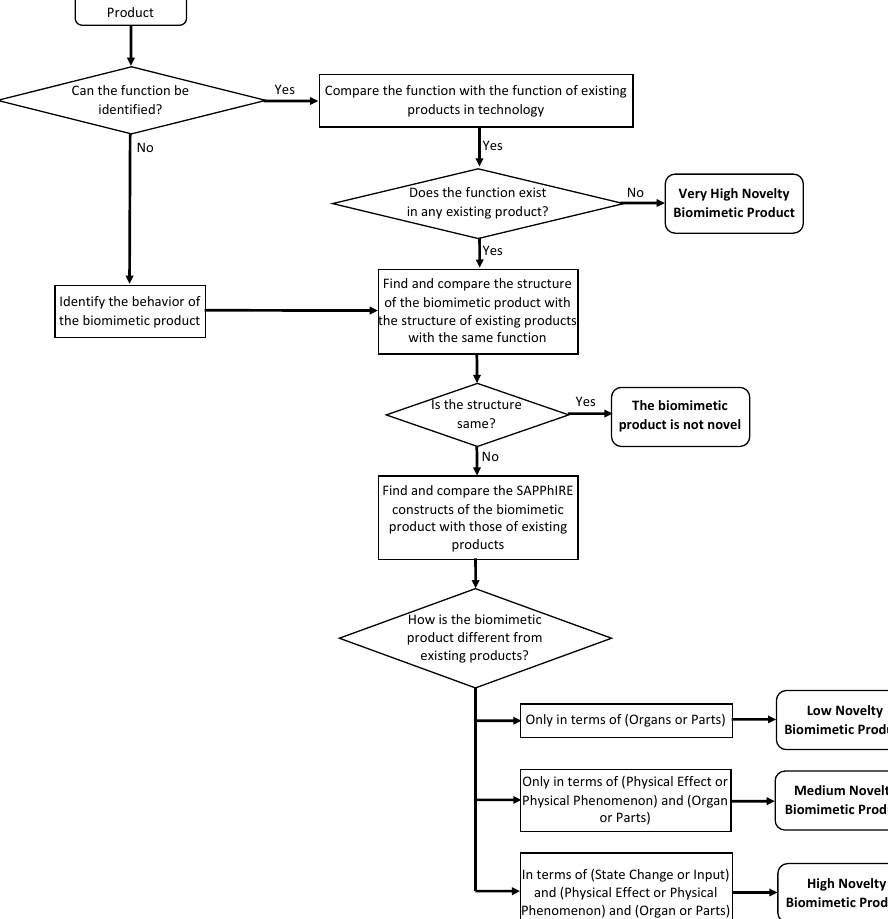
Figure 3. Flowchart for assessing novelty of biomimetic products, adapted from Sarkar and Chakrabarti [25].